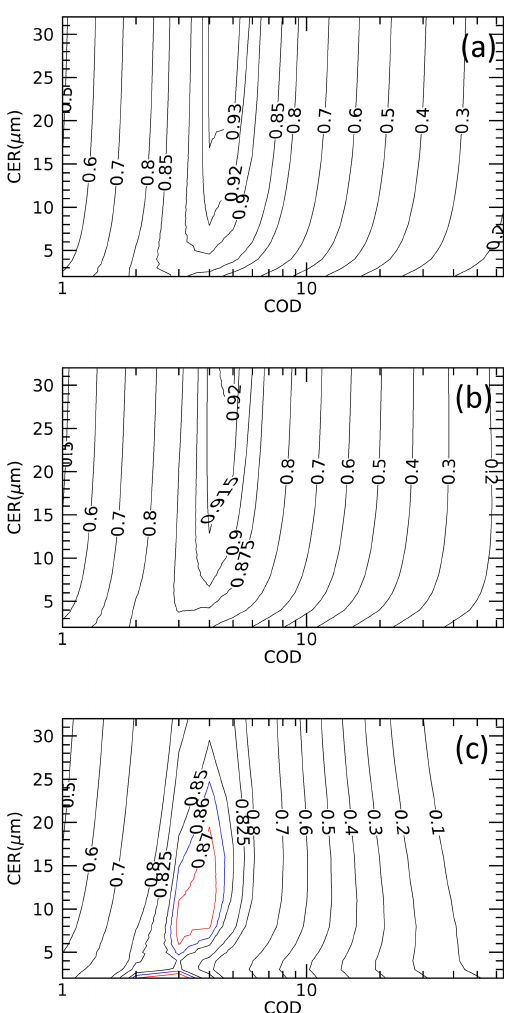
Figure 4. Contour plots of transmittances at the wavelengths of (a) 0.87, (b) 1.02, and (c) 1.627µm for the solar zenith and azimuth angles of 30 and 0 ◦ , respectively. The transmittance values are given within the contour lines. Different colors are used for 1.627µm to make it easy to distinguish. COD is the cloud optical depth; CER is the cloud particle effective